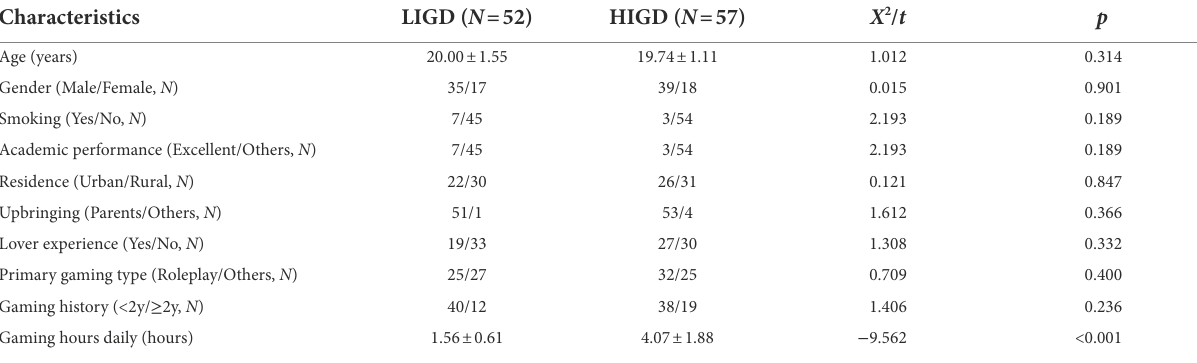
TABLE 1 Basic information of the study sample.